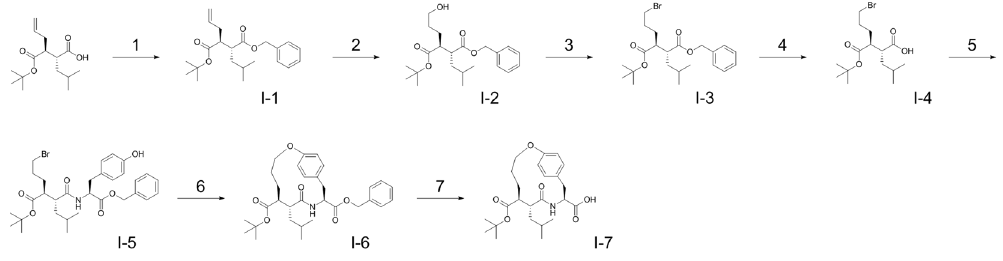
Figure 3. Synthesis of an anti-succinate-based macrocyclic acid intermediate ( I-7 ).